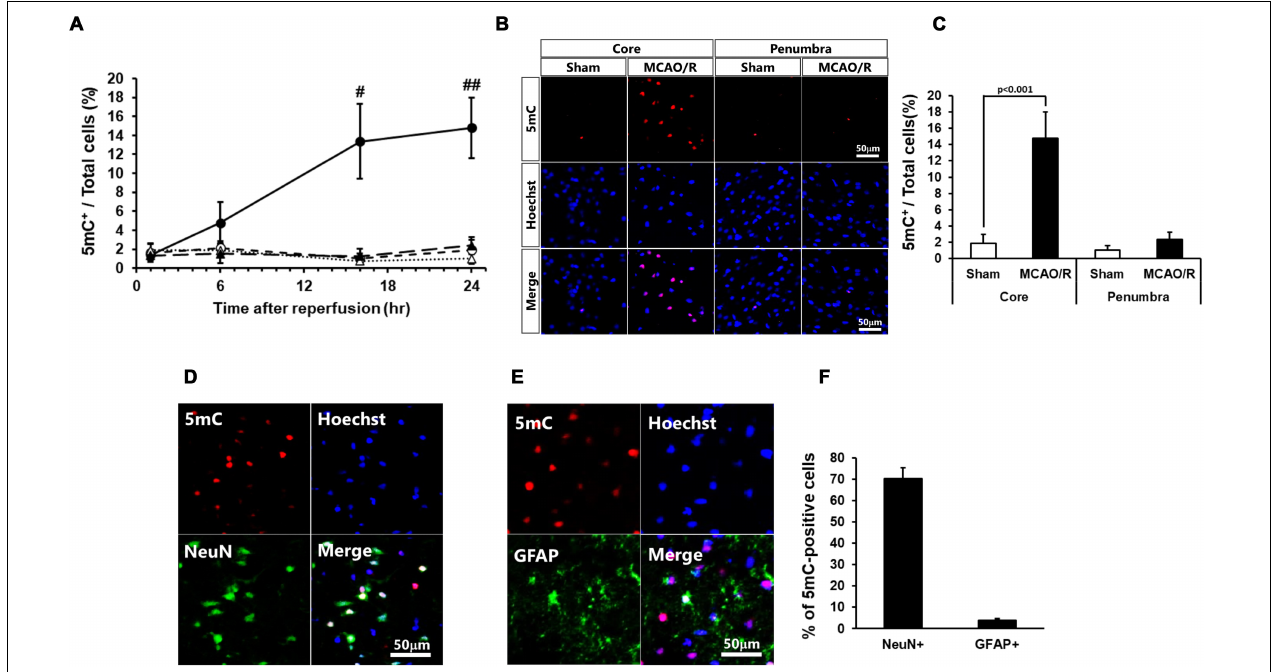
FIGURE 1 | (A) Time course of changes in the number of 5mC-positive cells in the core regions (circle) and penumbra regions (triangle) of the sham-operated (open) and ischemic (closed) rats. In these experiments, 6,404–7,845 cells in the core and 2,058–2,404 cells in the penumbra at 1 h, 5,675–8,572 cells in the core and 2,088–2,699 cells in the penumbra at 6 h, 3,699–7,448 cells in the core and 1,896–2,675 cells in the penumbra at 16 h, and 3,585–7,840 cells in the core and 1,919–2,622 cells in the penumbra at 24 h after surgery were counted per animal. Values represent the means ± SD ( n = 4–7 rats per group). # , ## Significant difference against the sham-operated group of same time point ( # p < 0.01, ## p < 0.001). (B,C) Immunostaining images of 5-methylcytosine (5mC) in the ischemic core and penumbra 24 h after surgery (B) and ratio of 5mC-positive cells to total cells (the number of Hoechst-positive cells; C ). (D,E) Double-immunostaining images of 5mC and NeuN (D) and 5mC and GFAP (E) in the core region of 24 h after surgery. (F) Ratio of NeuN- and GFAP-positive cells to 5mC-positive cells in the ischemic core 24 h after surgery. Values represent the means ± SD ( n = 6 rats per group). The scale bar represents 50 µ